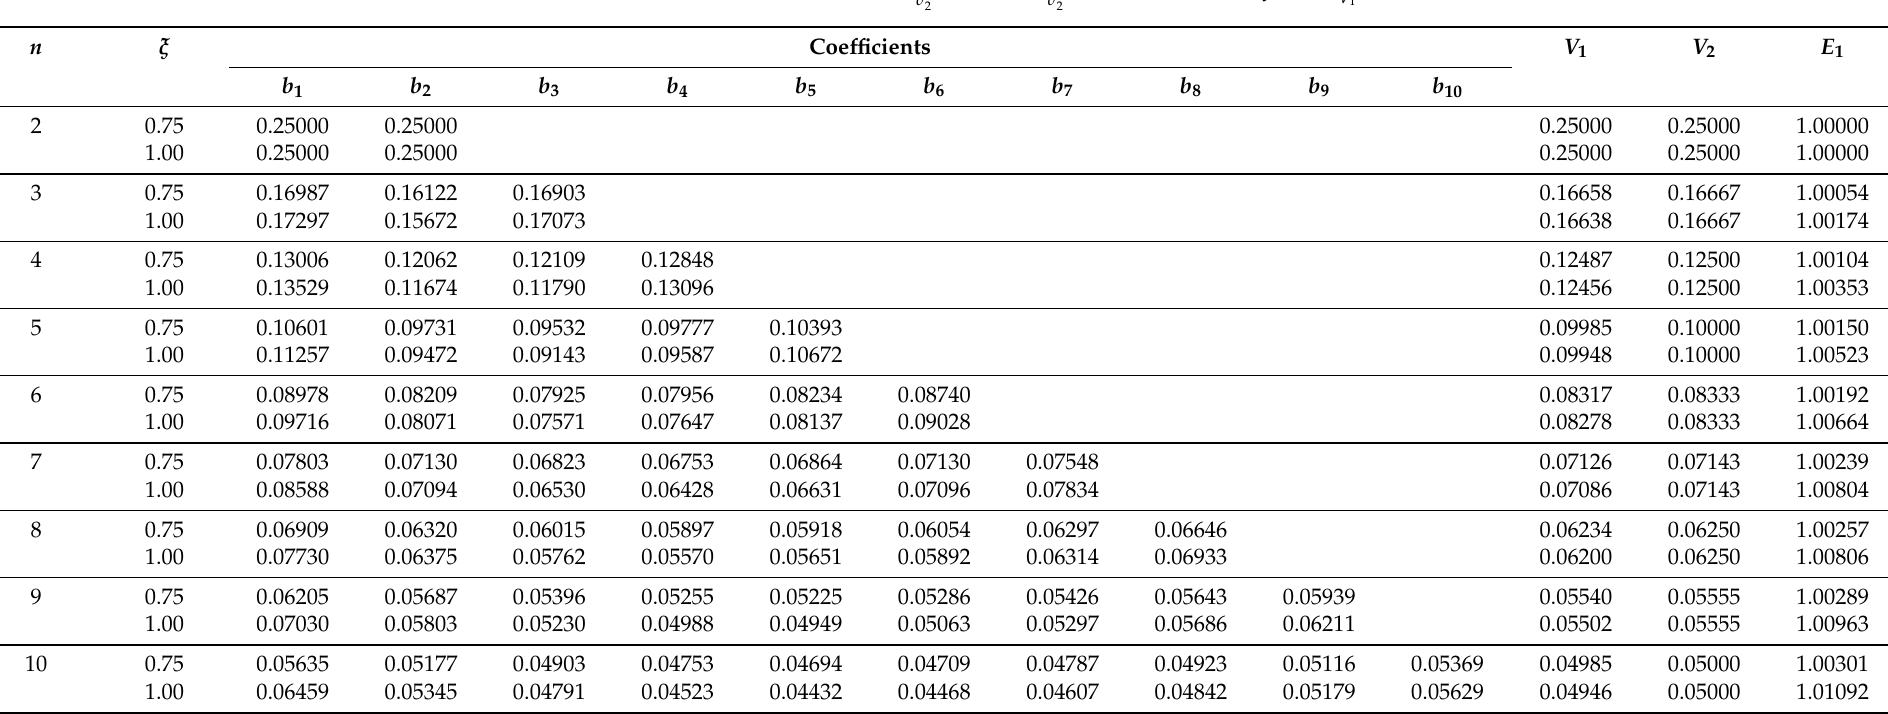
Table 4. The coefficients b r , r = 1,2, . . . , n , in the BLUE , V 1 = Var ( ˜ σ 2 )